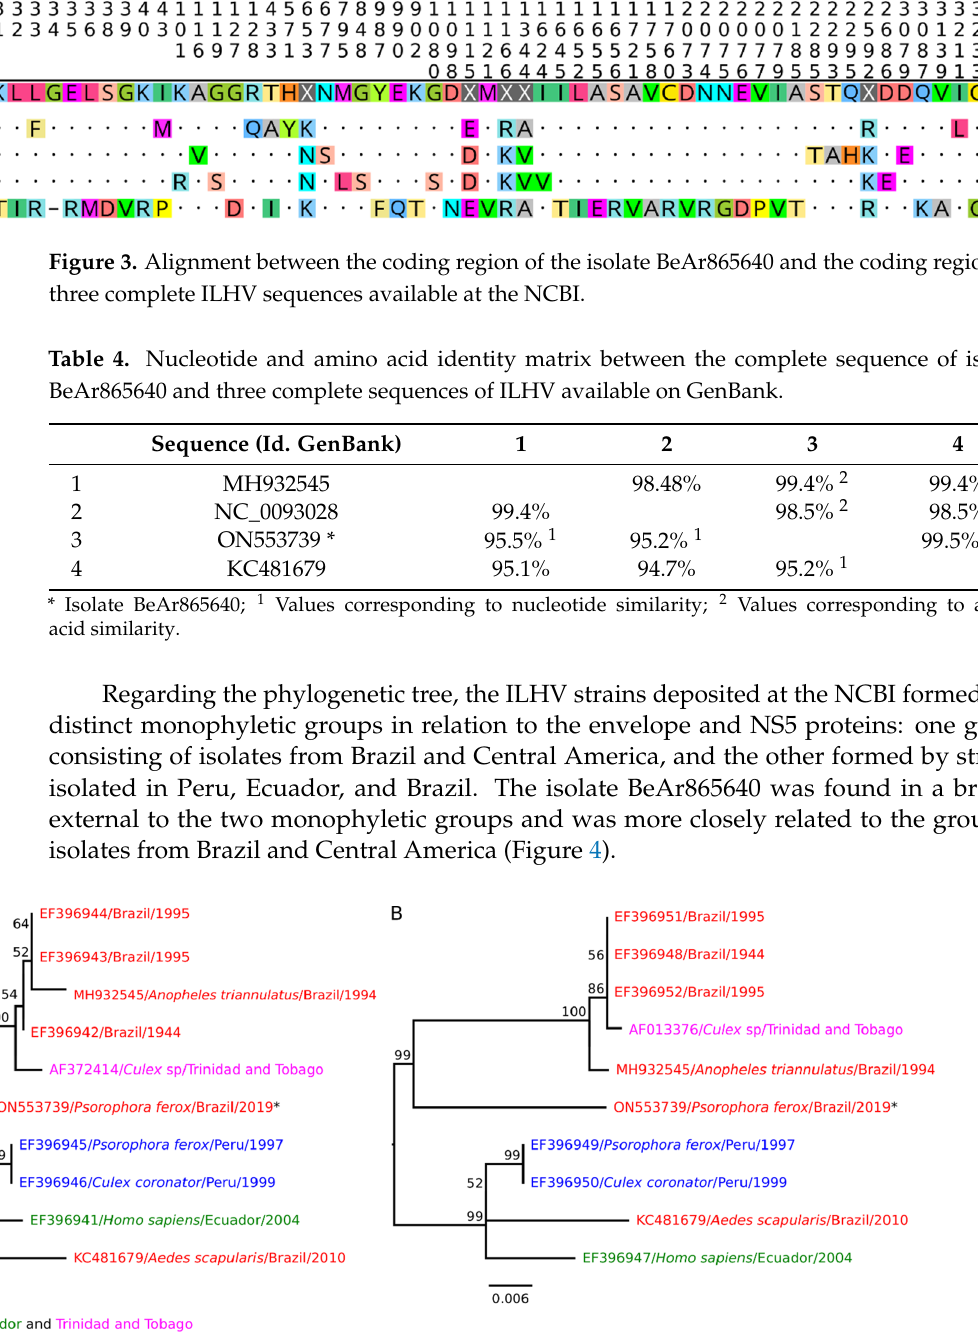
Figure 4. Phylogenetic relationship between the coding regions of the envelope proteins ( A ) and NS5 ( B ) of the isolate BeAr865640 (GenBank id. ON553739), with partial sequences referring to the coding regions of envelope proteins and NS5 of ILHV strains available at the NCBI. The Bootstrap values situated above branches represent the percentages derived from 1000 replicates, and the scale bar represents the nucleotide substitution rate. * Isolate BeAr865640.